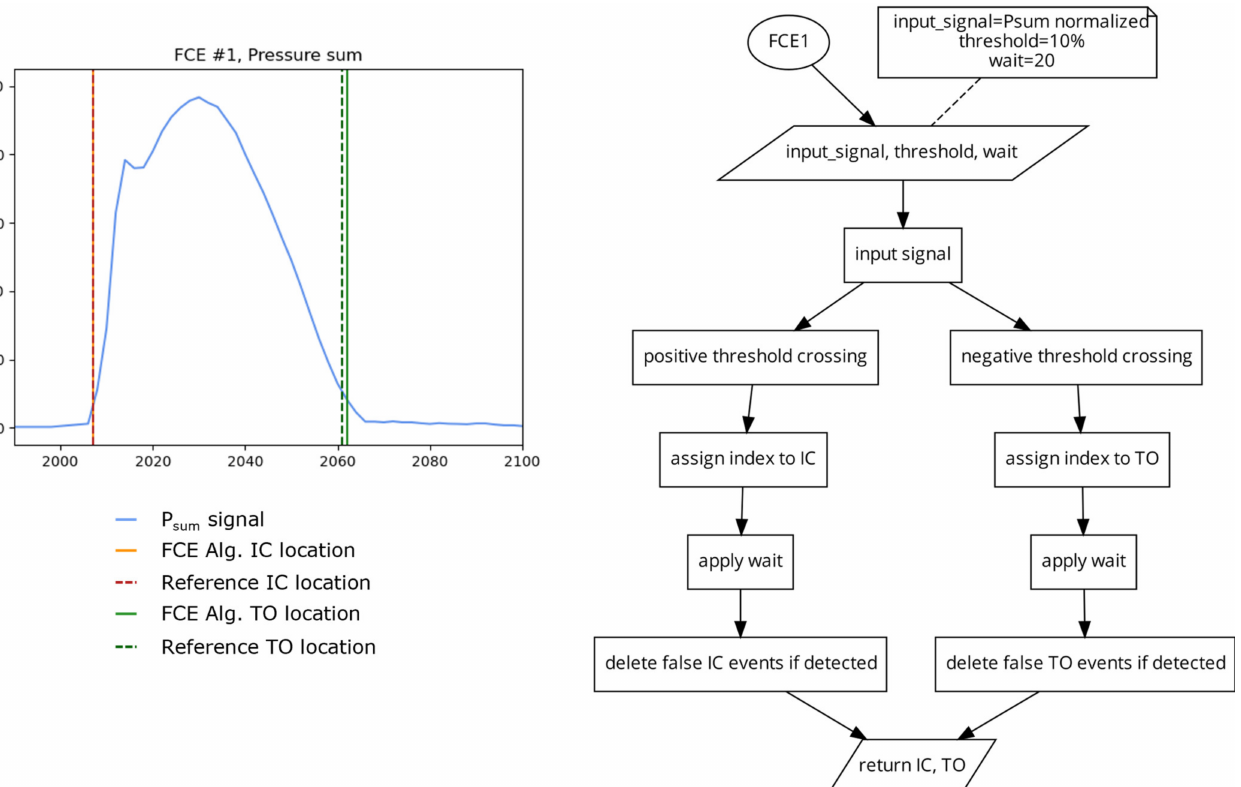
Figure 4. Plot ( left ) displaying a single stride and the location of the reference FCEs (dashed vertical lines) and the FCEs (solid vertical) determined by the FCE1 algorithm ( right ) using a 10% of the maximum signal threshold on the P sum